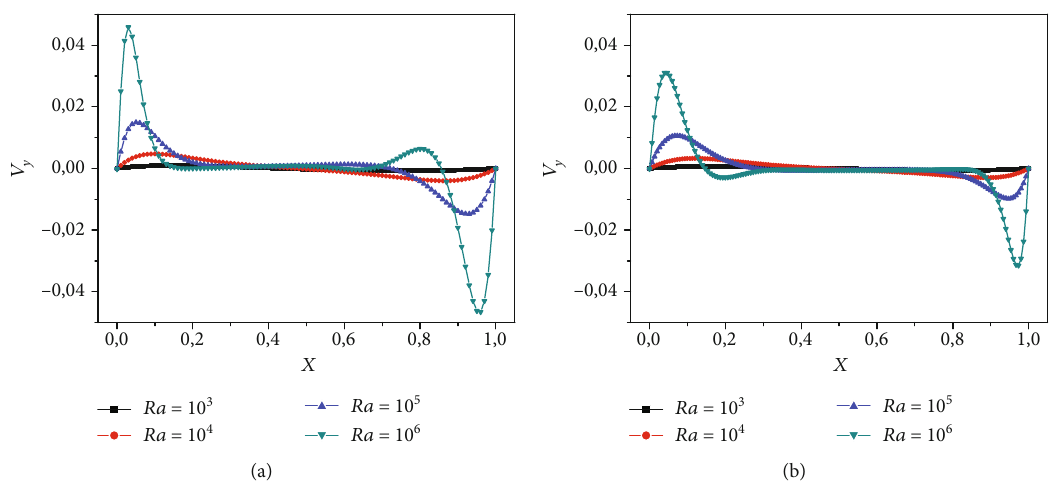
Figure 7: y -component velocity pro fi les as a function of x -coordinate for di ff erent Rayleigh numbers Ra , for a hot (a) and cold (b) chip length of h = H /3 .